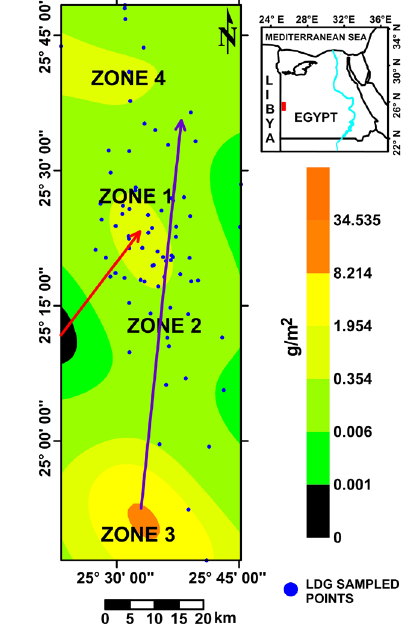
Figure 12. Map of the LDG distribution model. Red arrow: line of maximum gradient in LDG surface mass density. Purple arrow: line of LDG